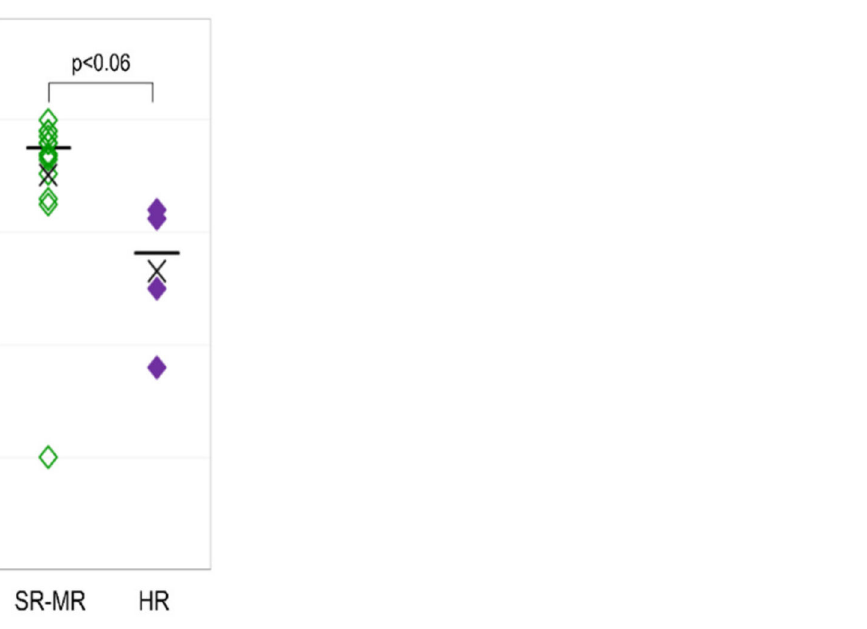
Figure 1. Bone marrow lymphoblasts of pediatric patients at diagnosis. Bone marrow lymphoblasts (in %) from pediatric patients with high risk (right column) compared to patients with standard and medium risk (left column) at